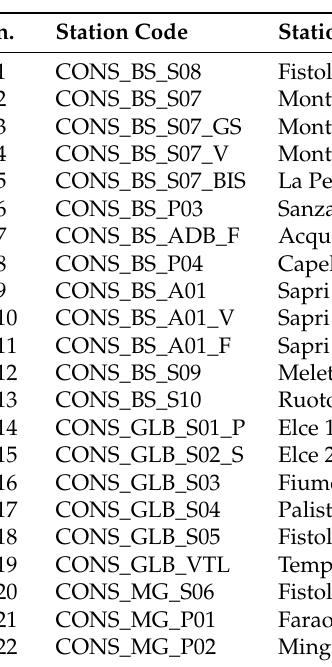
Figure 1. In the upper left-hand corner, shown in yellow is the entire province of Salerno with evidence (in red) of the area under study. In the larger picture, the locations of the 22 groundwater springs and the corresponding drainage basins areas investigated are shown: Bussento (in red), Mingardo (in blue) and Gelbison (in yellow). Table 1. Monitoring stations: progressive number, station code, station name and corresponding hydrogeological units. The station code is made of three strings of alphanumerical characters separated by an underscore. The first one represents the water system manager (CONSAC), the second one is the fluvial basin to which the station belongs (BS = Bussento, GLB = Gelbison and MG = Mingardo) and the third group of alphanumerical characters represents the location where the drinking water was sampled (S = spring, F = fountain, P = well and A =